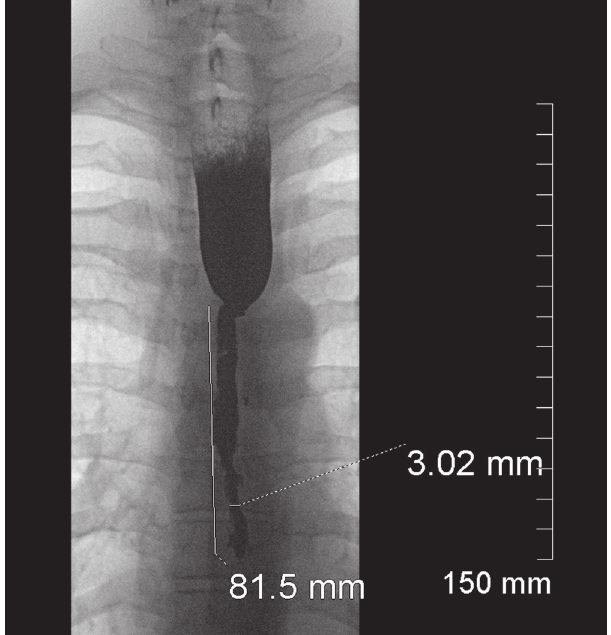
Figure 3) Barium upper gastrointestional series five months postingestion demonstrating persistent